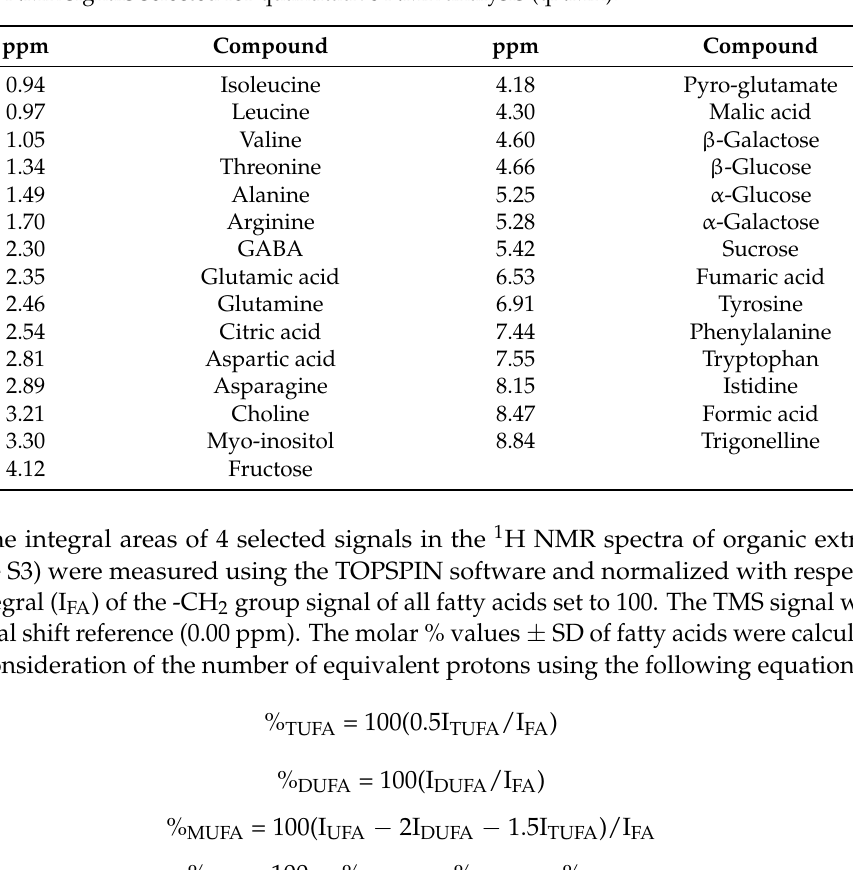
Table 2. NMR signals selected for quantitative NMR analysis